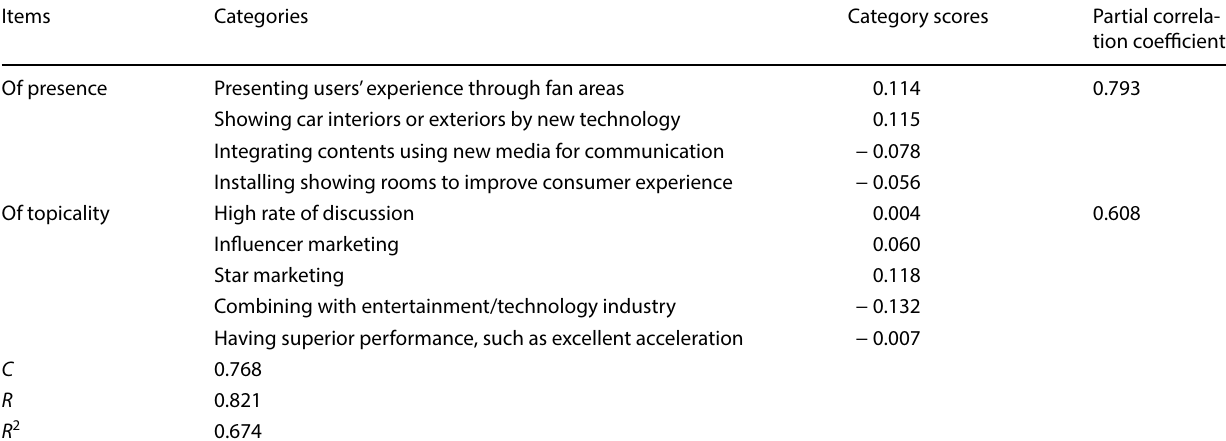
Table 5 The partial correlation coefficients, the category scores, and the coefficient of determination for the factor of